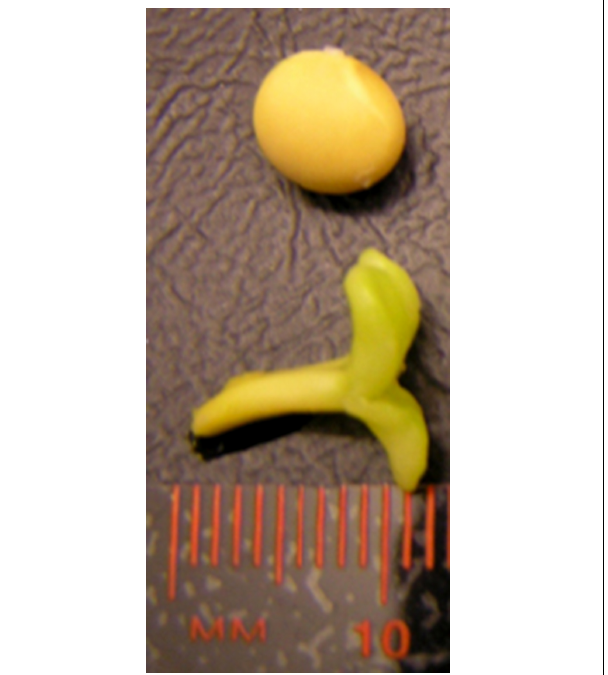
FIGURE 2 |The comparison of the size and morphology of a mature seed and a mature somatic embryo is shown. Note that the somatic embryo can exceed the seed’s size, and the axis is enlarged compared to the